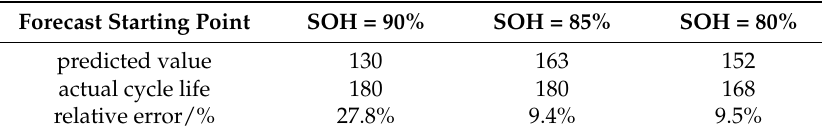
Table 4. Probability prediction results of No. 18 lithium battery cycle